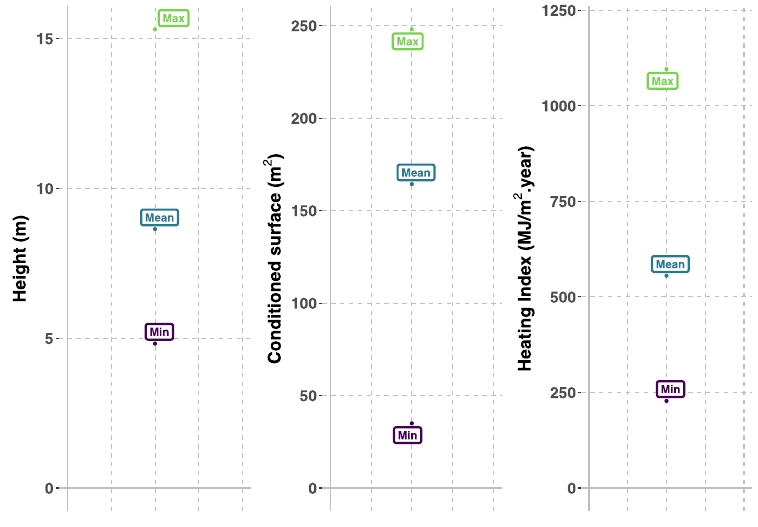
Figure 2. Main dataset characteristics.